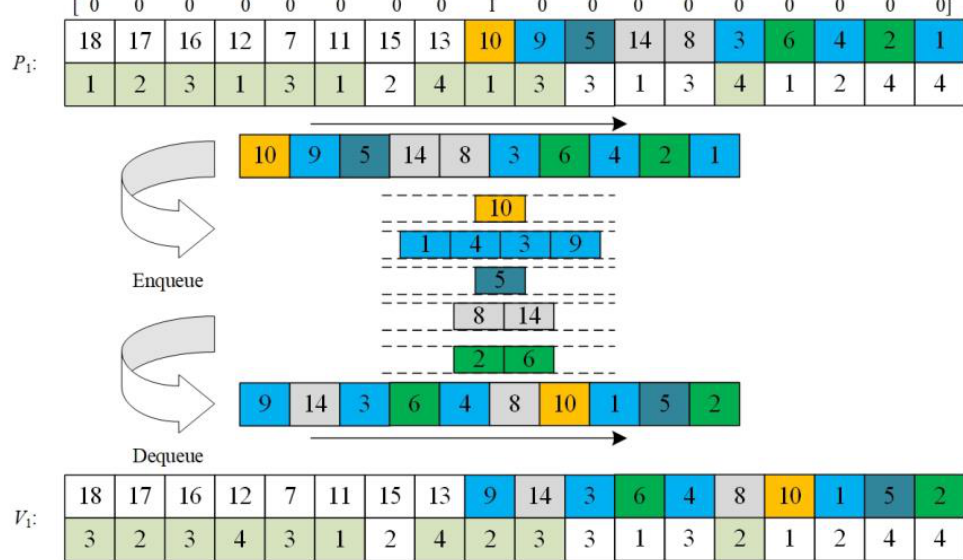
Figure 8. The offspring individual obtained by applying the above-mentioned random mutation method based on the mutation row vector.